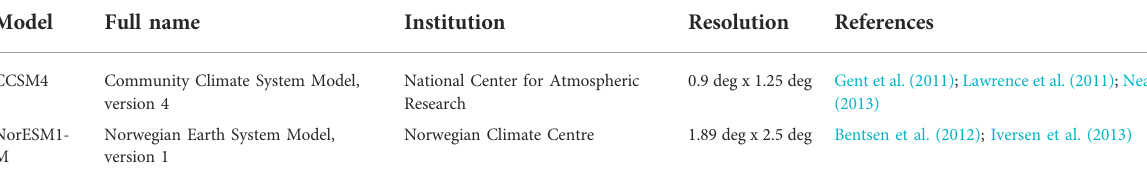
TABLE 1 Model characteristics.